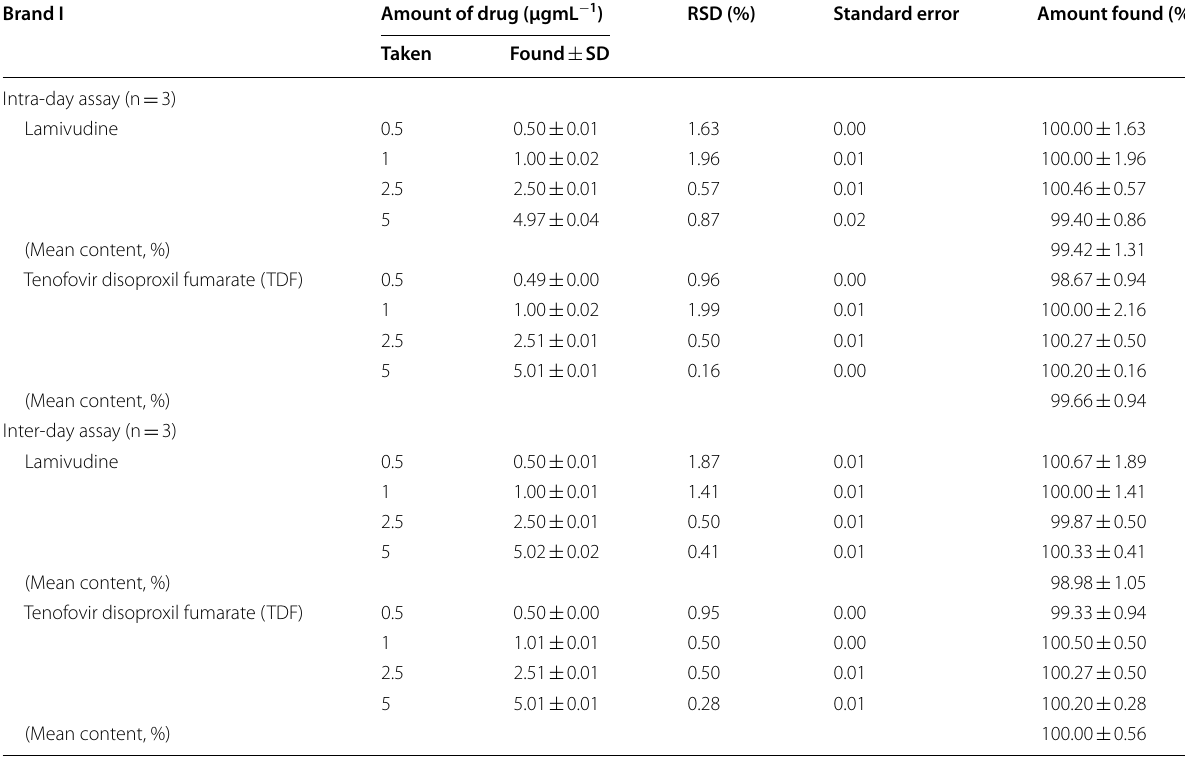
Table 3 Summary of precision and accuracy studies for HPLC method